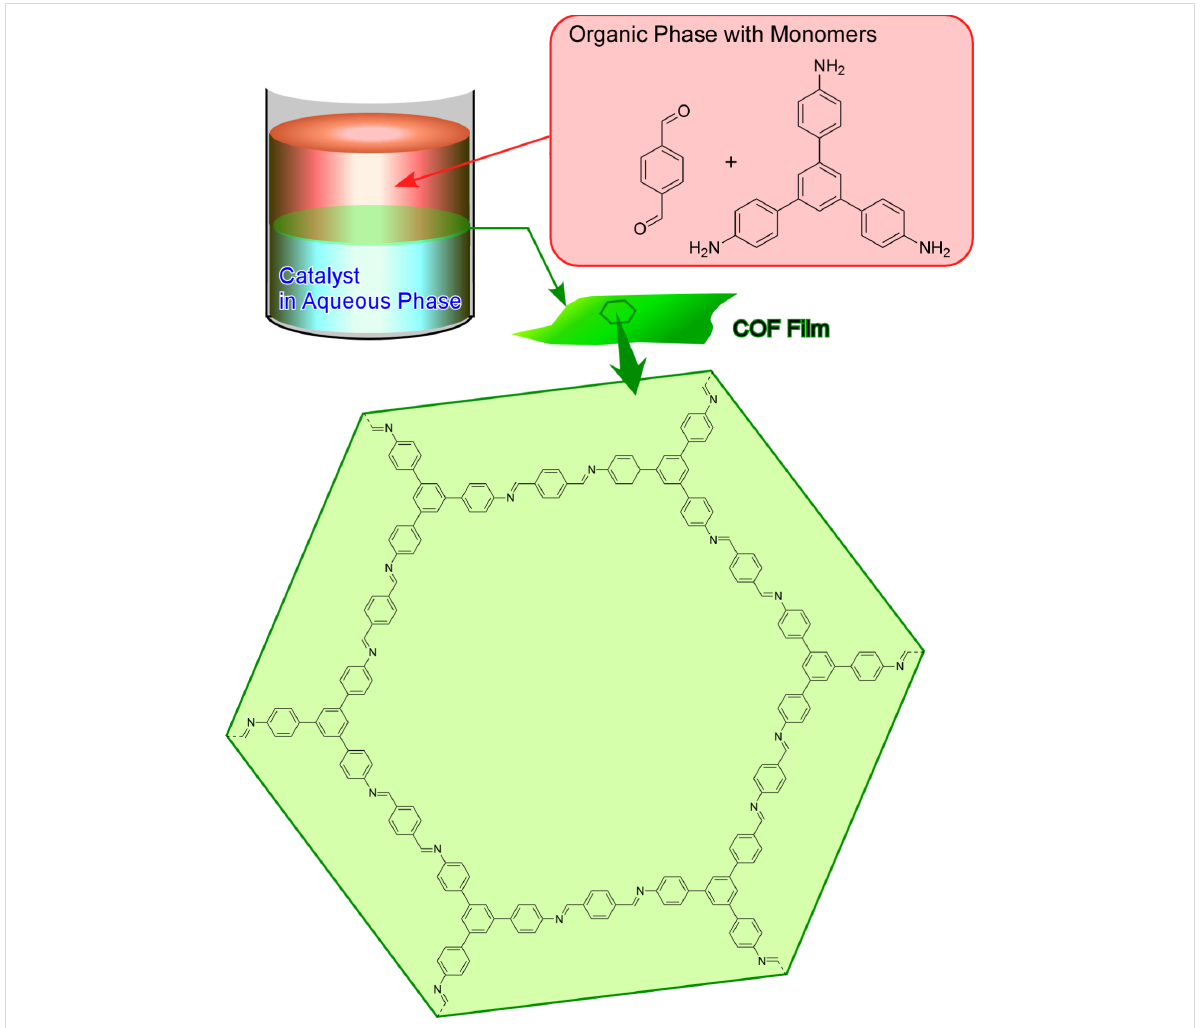
Figure 13: Confined polymerization at the interface by spatially segregating a catalyst from the COF monomers. The formation of imine at the inter- face of aqueous and organic layer yielded large-area, continuous COF